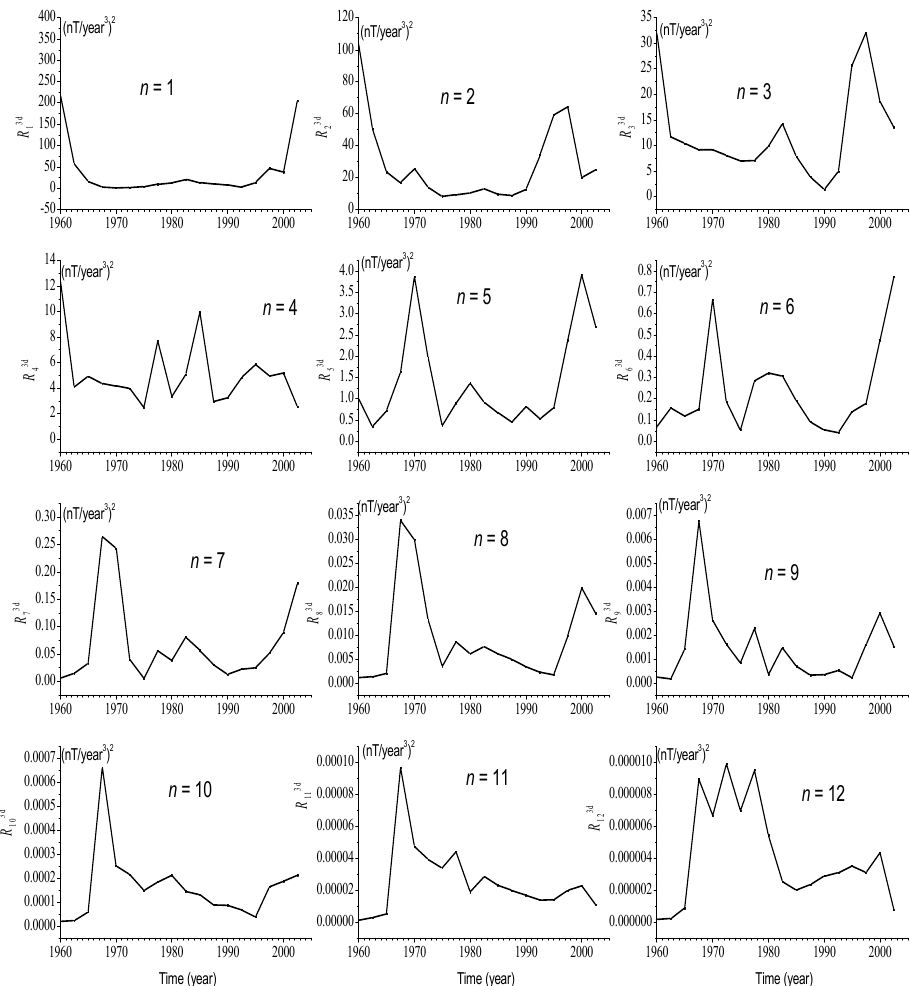
Fig. 11. Time variations of the spherical harmonic power spectra terms ( R 3 d n ) at the Earth’s surface.